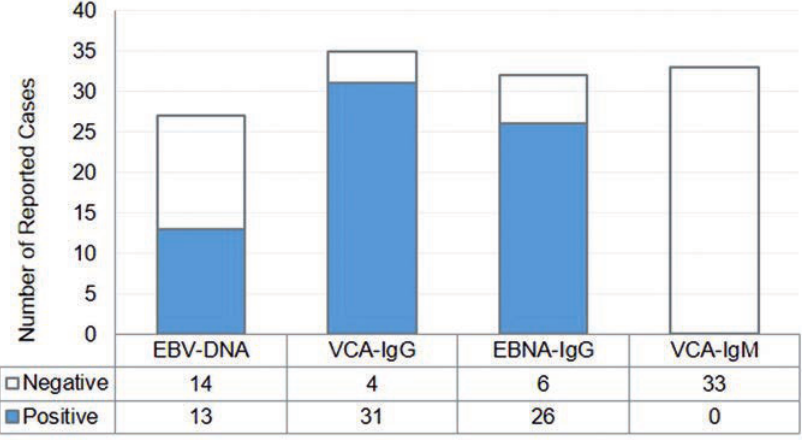
Figure 3. Peripheral Epstein-Barr virus data reported in cases of angioimmunoblastic T- cell lymphoma